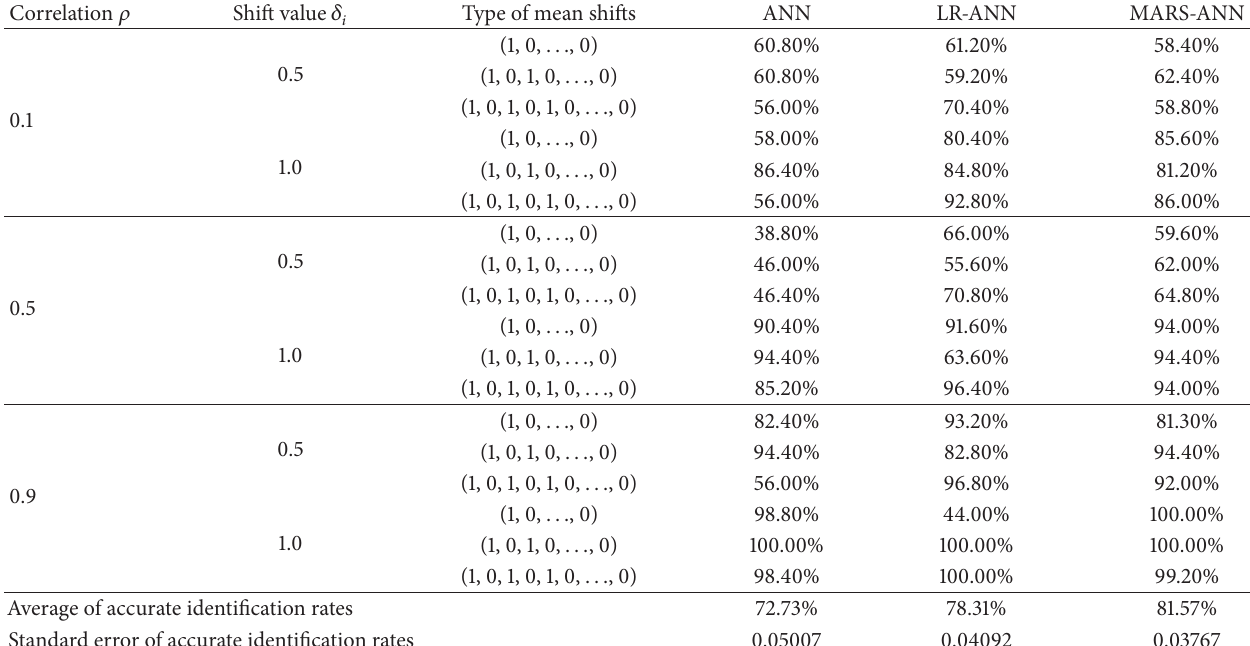
Table 10: Comparison of classification accuracy among the ANN, LR-ANN, and MARS-ANN models.